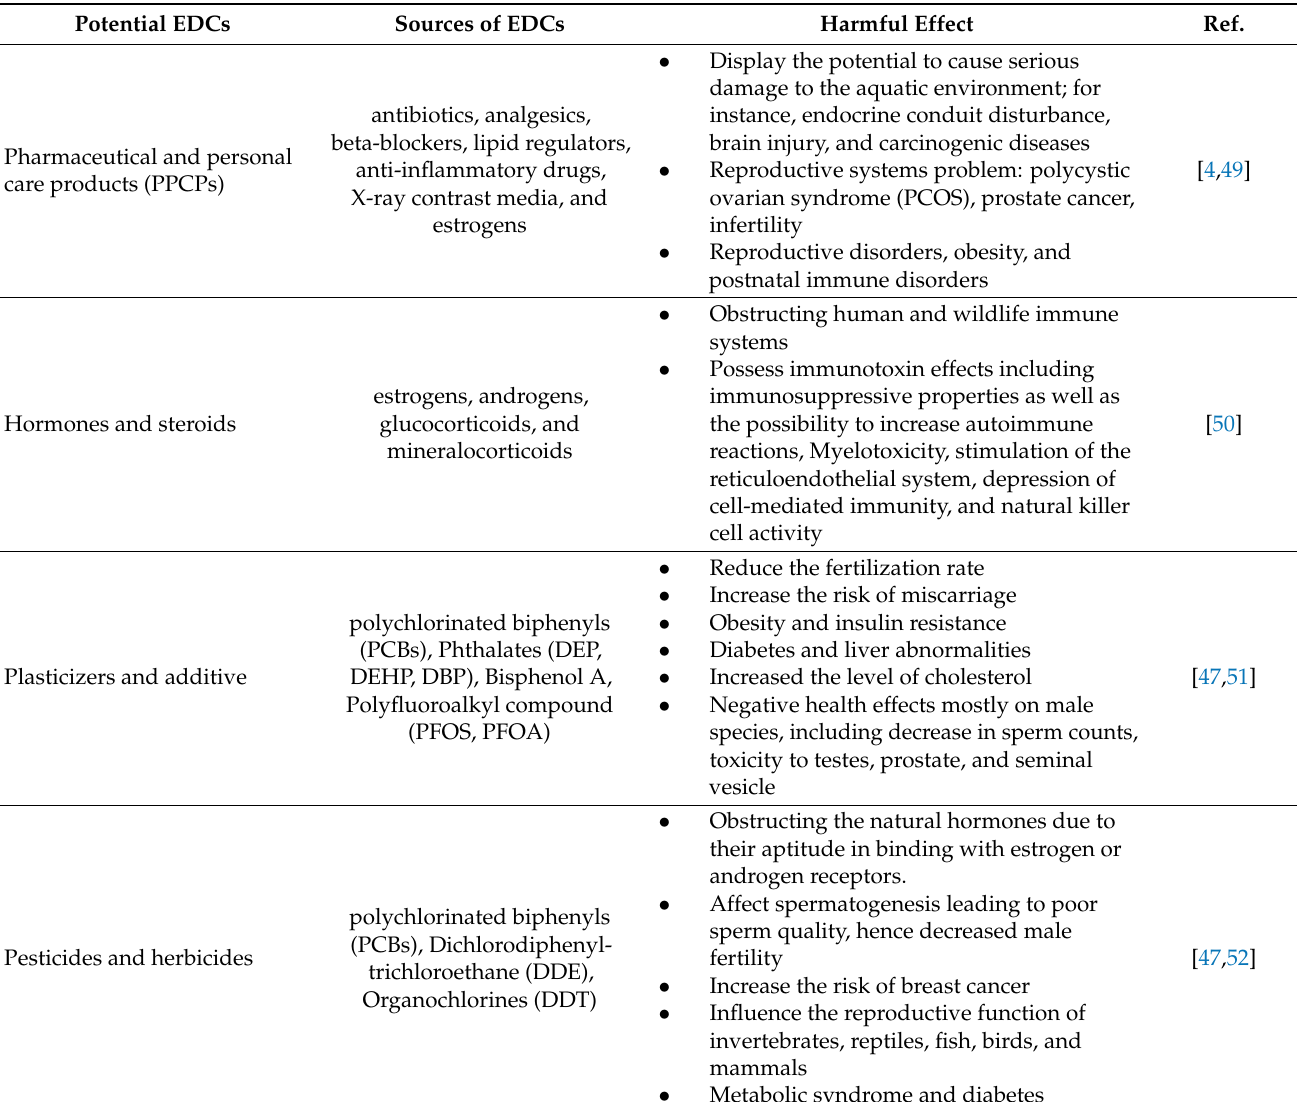
Table 1. Sources and harmful effects of endocrine disrupting chemicals